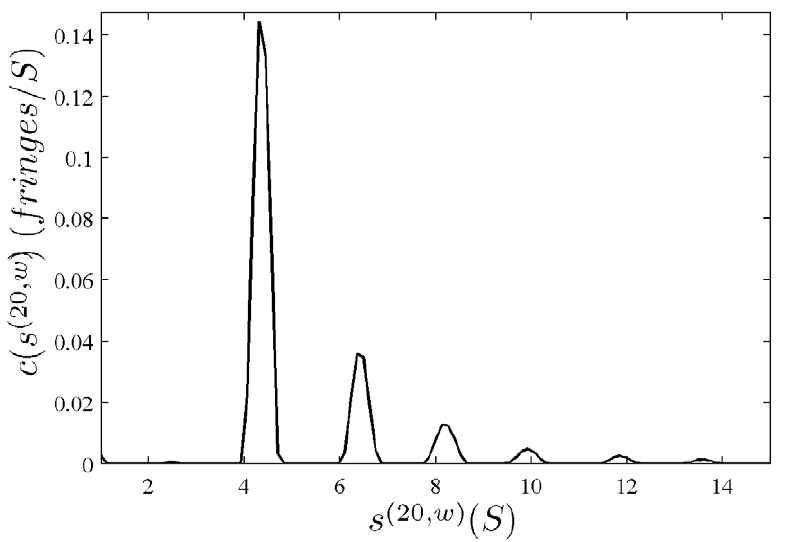
Figure 8. Sedimentation coefficient distribution for the global analysis of the BSA sample (Figure 7). Relative scaling factors a 2 = a 1 and a